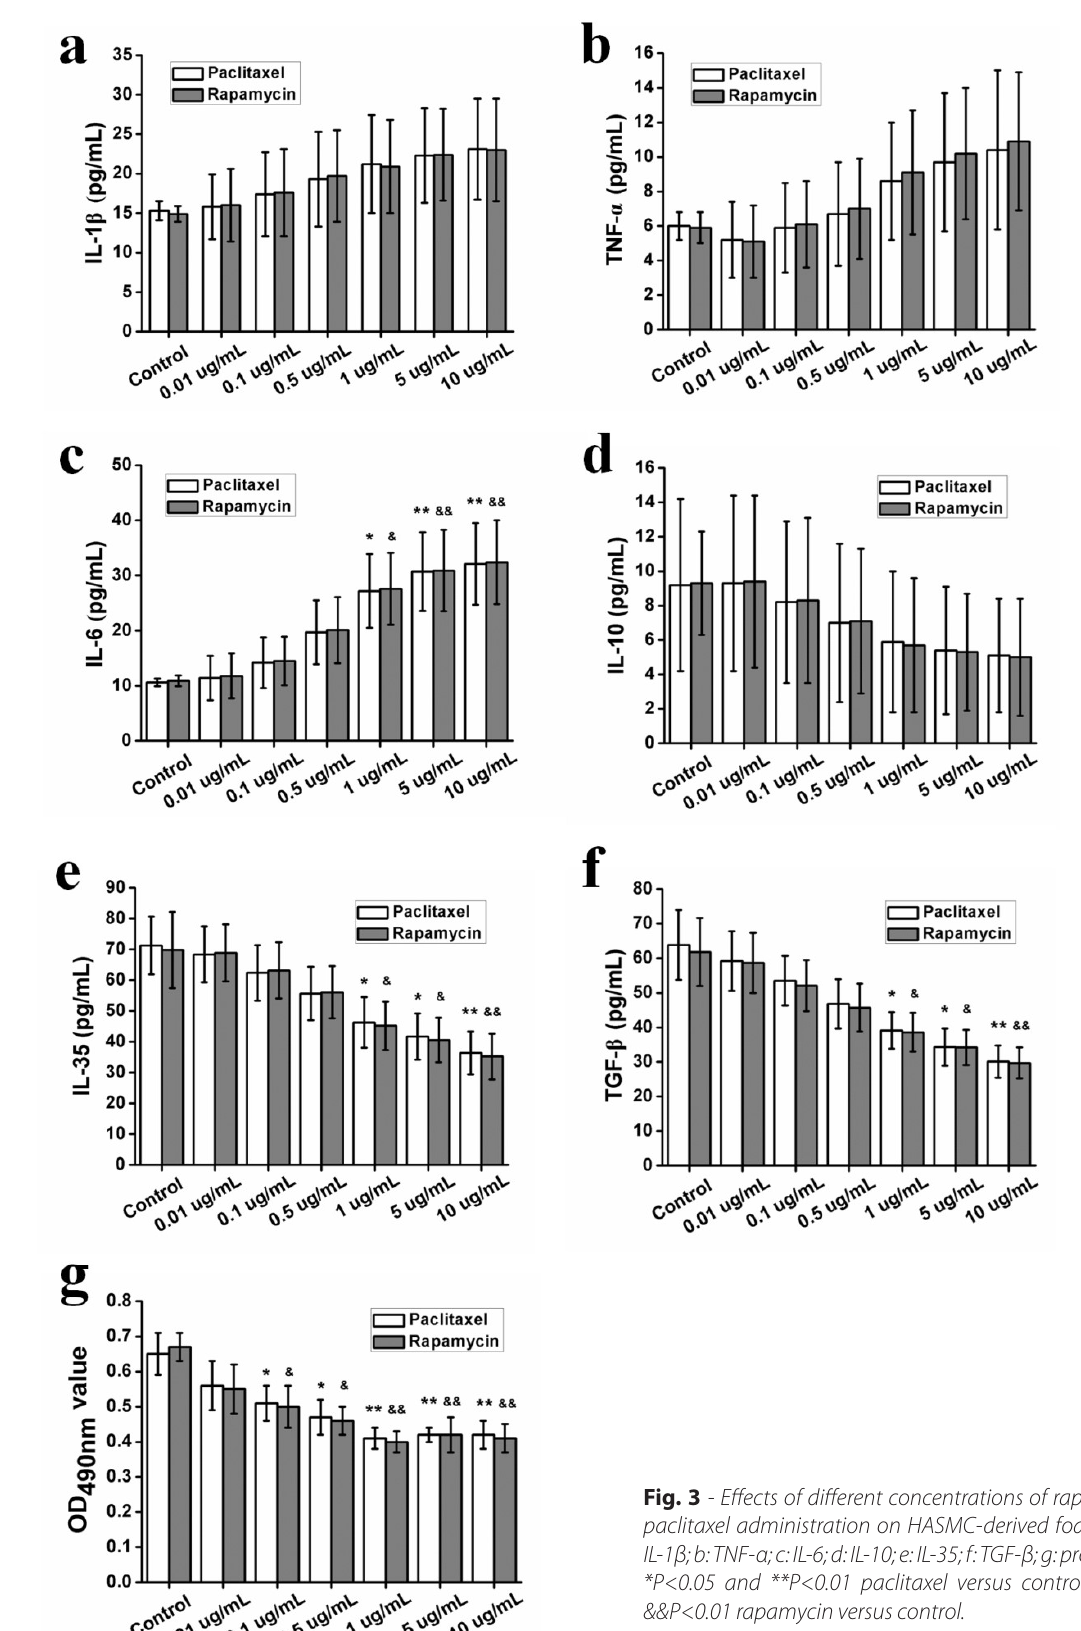
Fig. 3 - Effects of different concentrations of rapamycin or paclitaxel administration on HASMC-derived foam cells. a: IL-1β; b: TNF-α; c: IL-6; d: IL-10; e: IL-35; f: TGF-β; g: proliferation. *P<0.05 and **P<0.01 paclitaxel versus control; &P<0.05 &&P<0.01 rapamycin versus